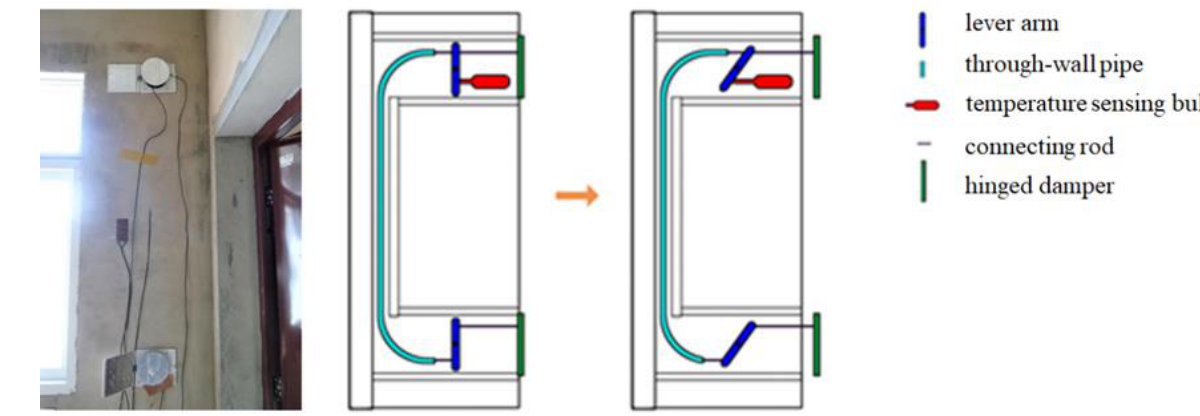
Figure 4. The photo and operation principle of temperature-controlled damper.